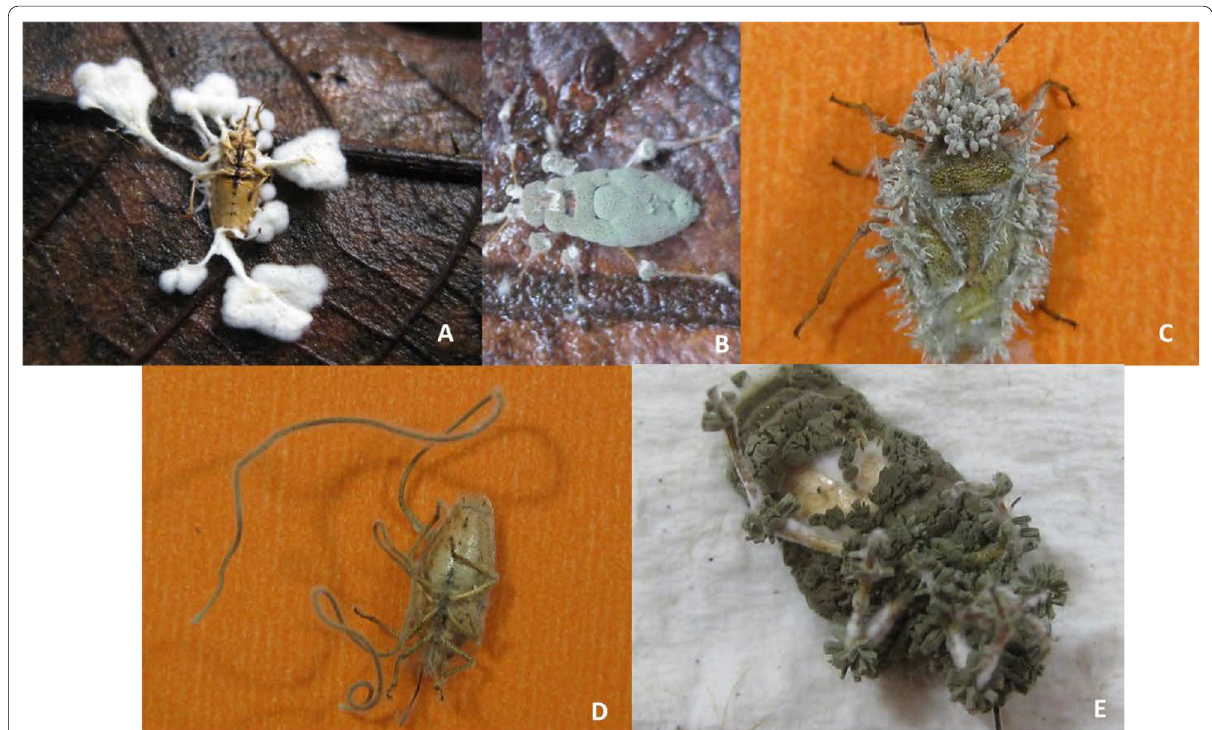
Fig. 3 Entomopathogenic fungi associated with Oebalus mexicana at hibernation sites in the Zináparo hill, Michoacán, México. A Beauveria , B Metarhizium in an alternate host in the field; C Isaria , D Hirsutella and, E Metarhizium in O. mexicana developed under laboratory